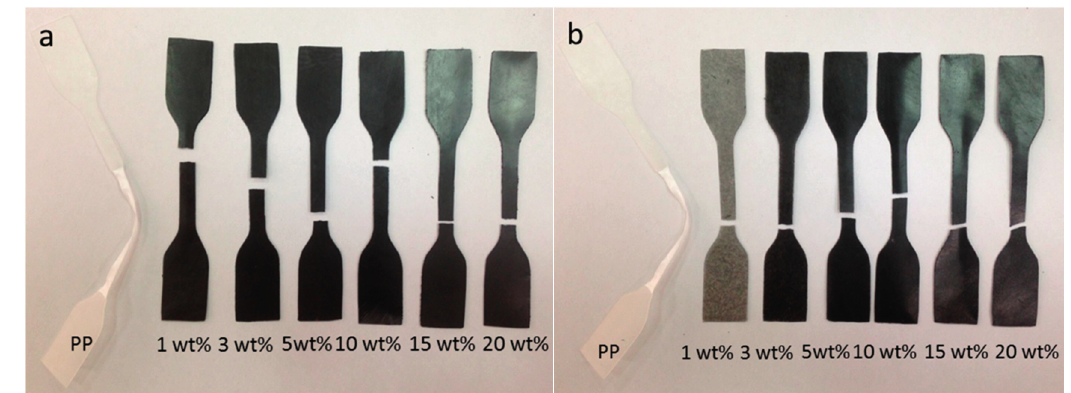
Figure 7. Stereomicroscopic images of the fractured samples: ( a ) PP/GNs composite and ( b ) PP/CF